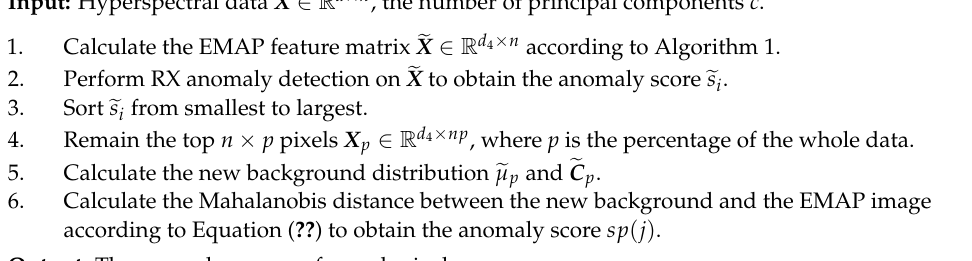
Algorithm 2: RRXEMAP